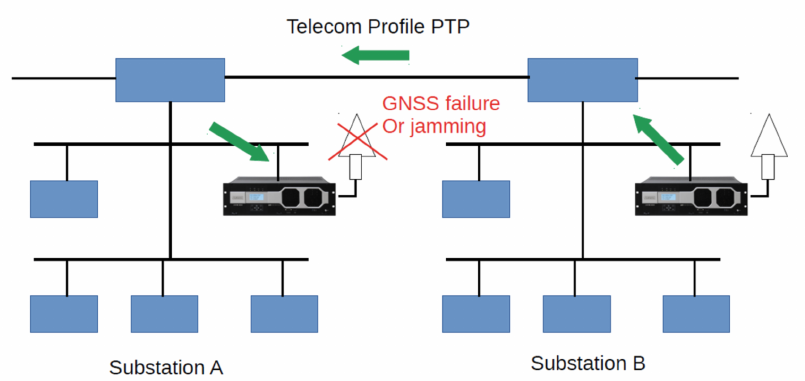
Figure 5. A time server in a substation that is experiencing a GNSS receiver failure or jamming receives time from a nearby substation using the PTP Telecom Profile.